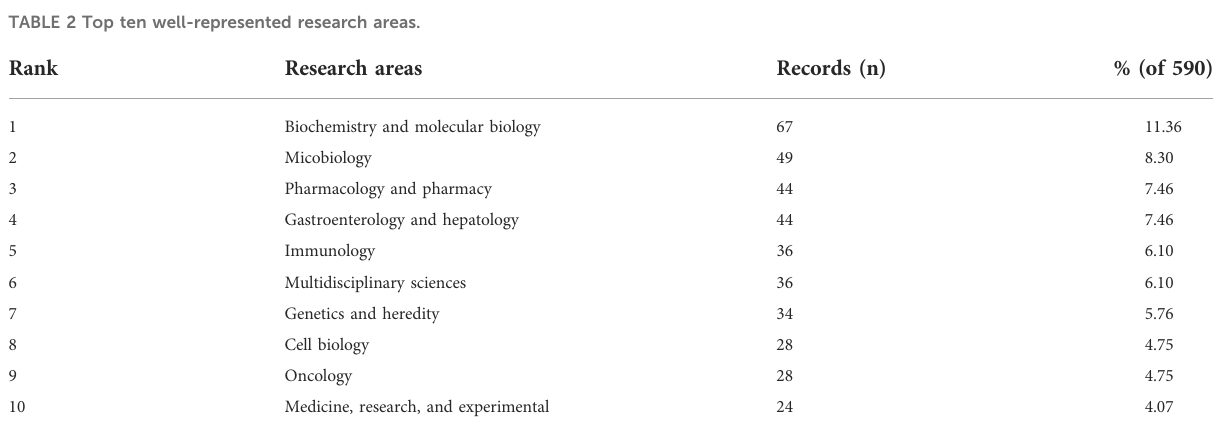
TABLE 2 Top ten well-represented research